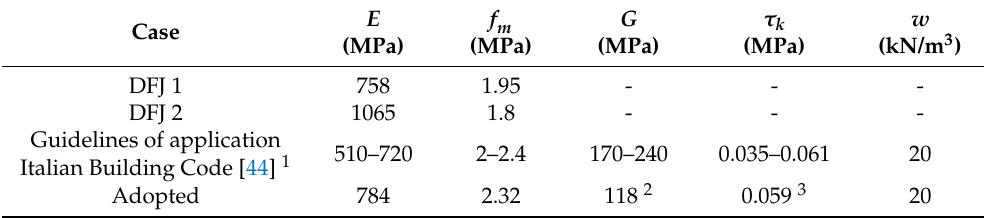
Table 3. Masonry mechanical properties obtained from the tests and adopted in the assessment: elastic modulus E , shear modulus G , masonry compressive strength f m , masonry shear strength τ k , specific weight w . Elastic and shear modulus are considered in cracked conditions.